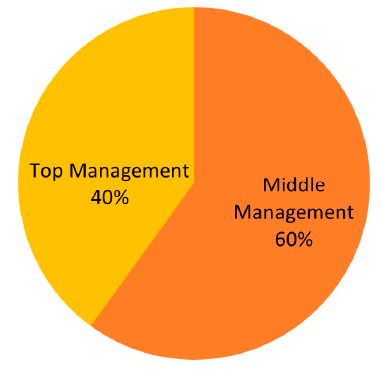
Figure 3. Management level of respondents.